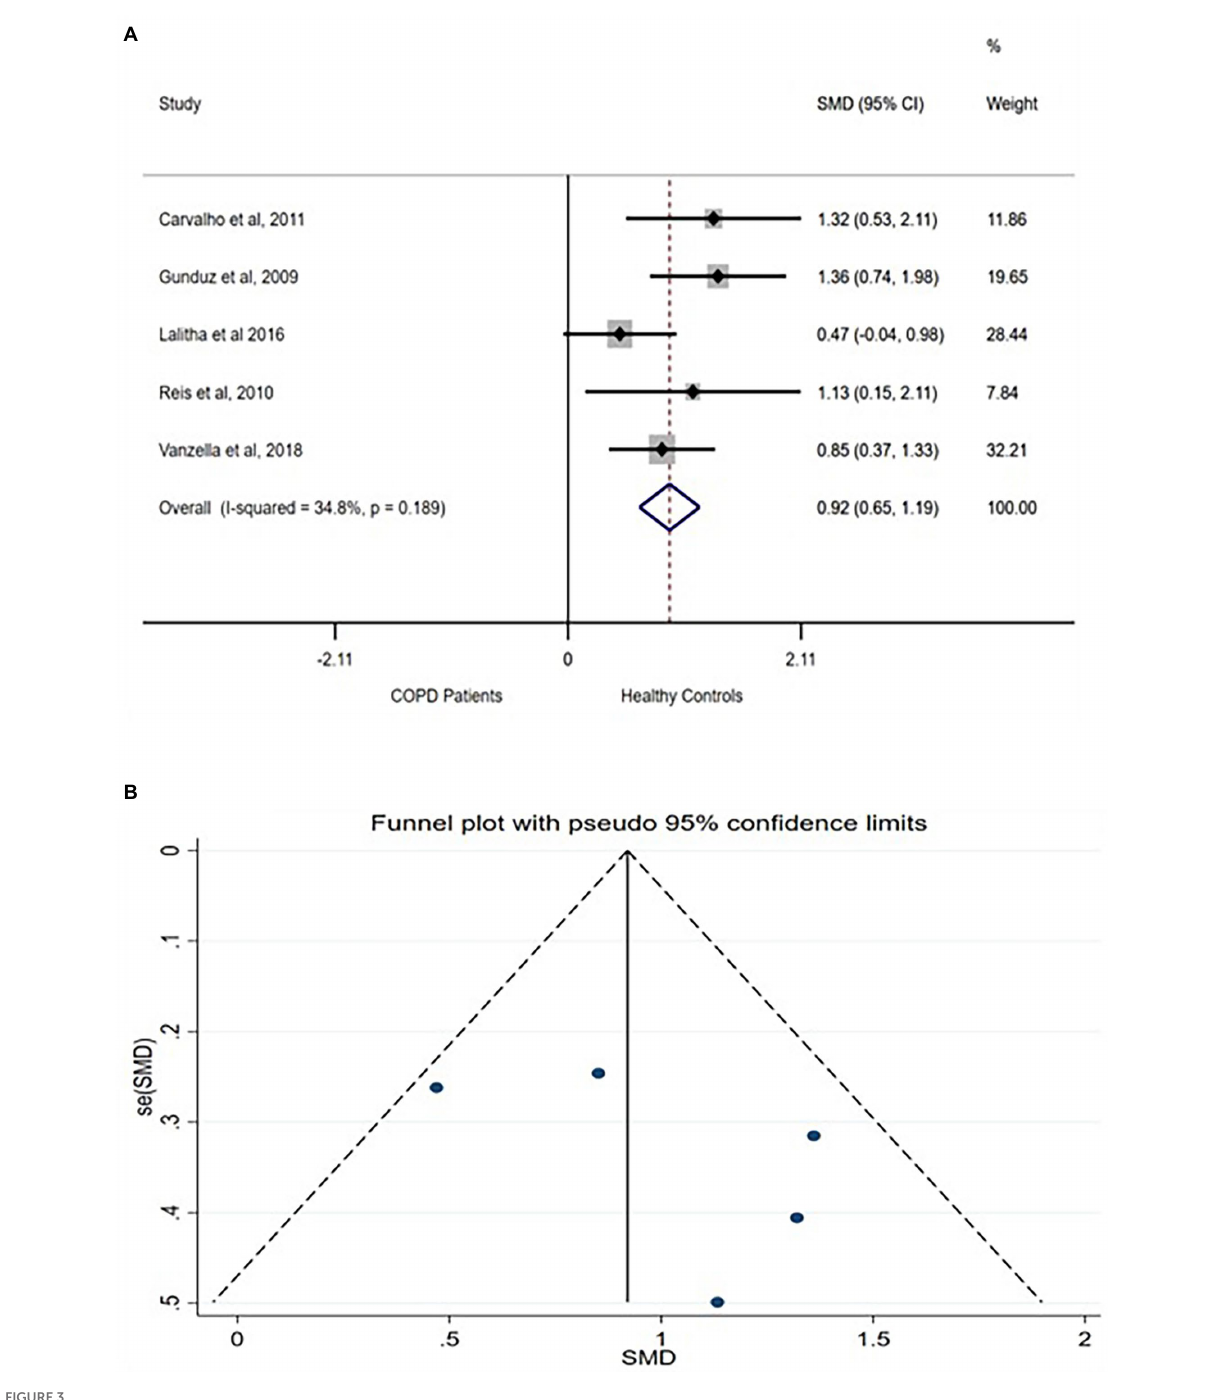
(Supplementary Figure S7A). Funnel plot showed not publication bias (Supplementary Figure S7B) and sensitivity test showed none of the analyzed studies exaggerated the effect size (Supplementary Figure S8).